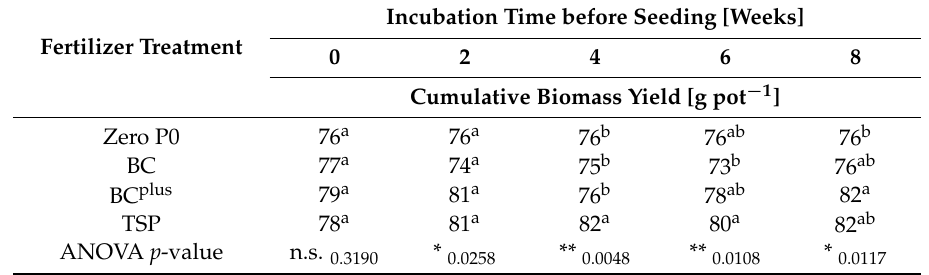
Table 2. Analysis of variance (ANOVA) 1 and Tukey-Kramer HSD t -test 2 on cumulative aboveground biomass (sum of 7 cuts) in dependence of fertilizer type and incubation time before seeding.